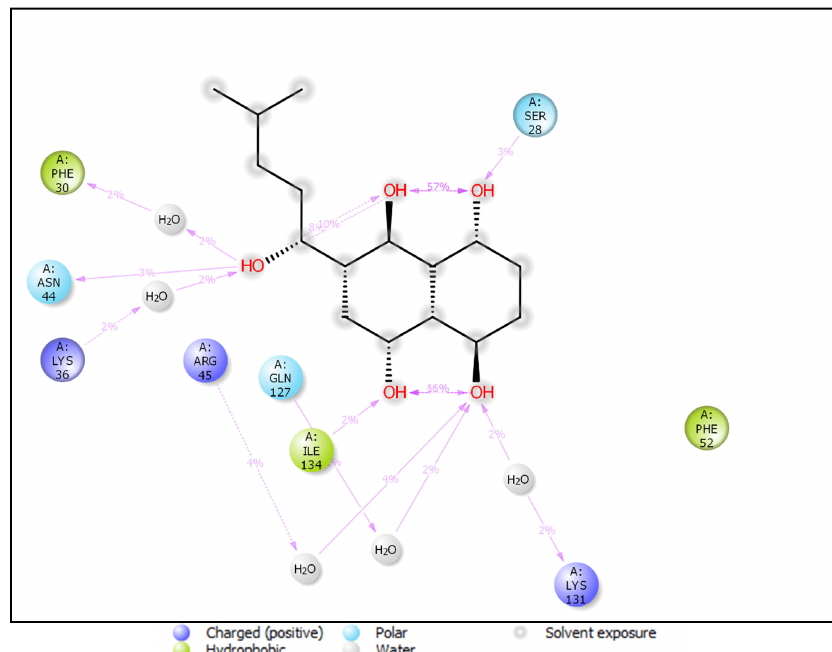
Figure 11. Protein-ligand complex interaction during the molecular docking simulation.